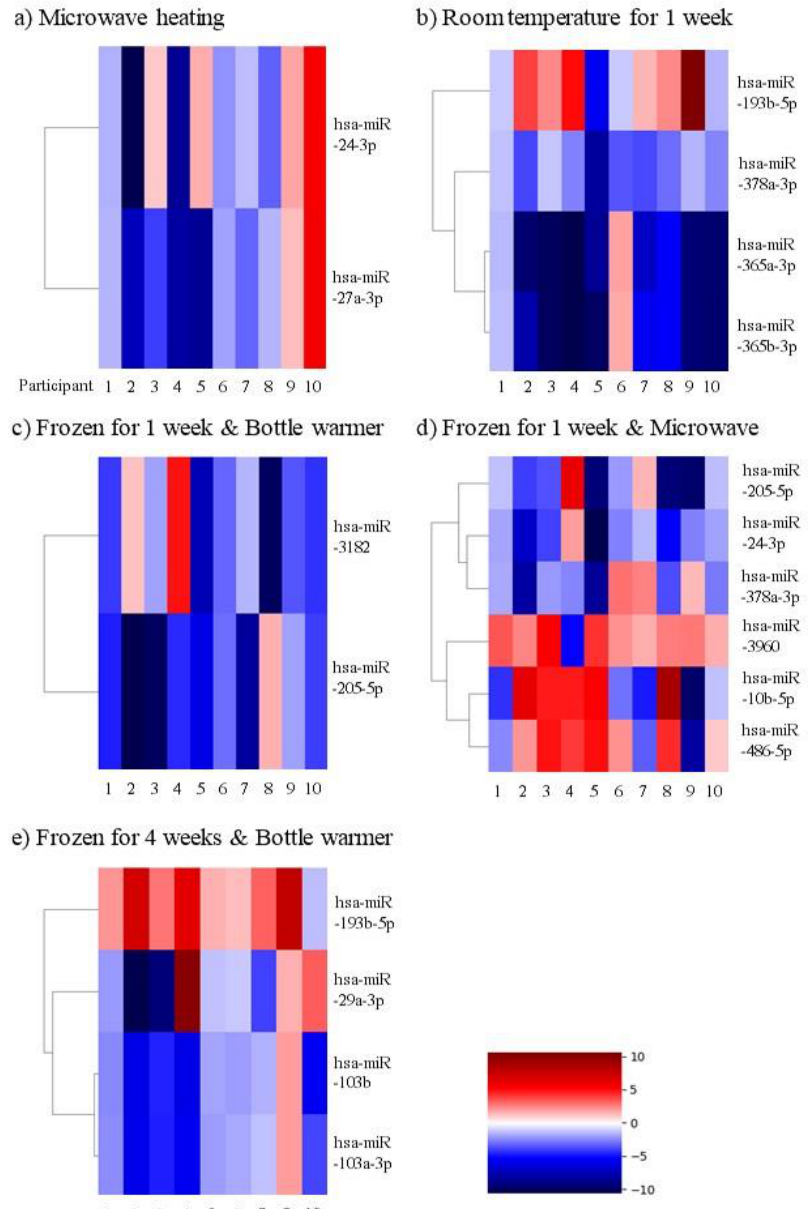
Figure 2. Heatmap of microRNAs showing the significant differences in expression levels compared with the control group.